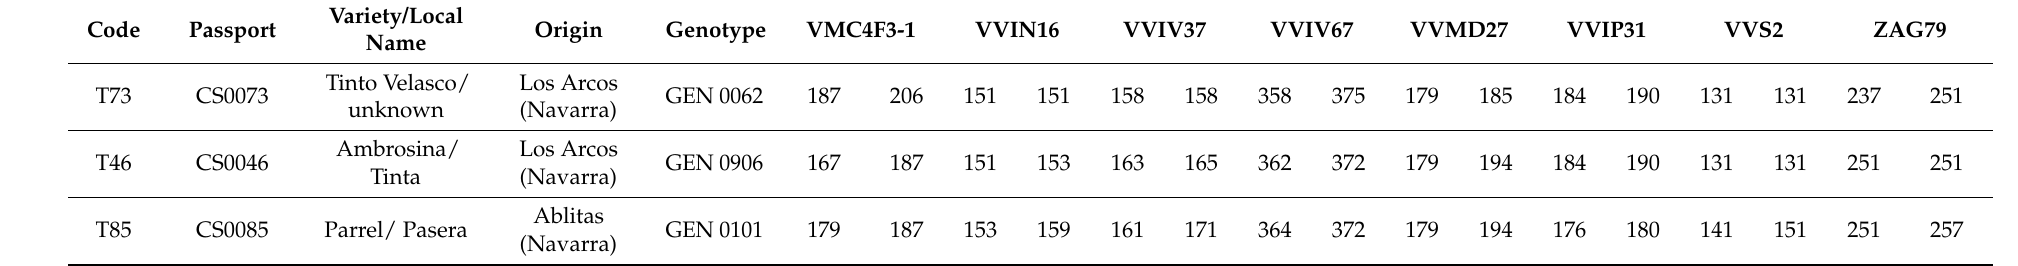
Table 3. Code, passport number, variety name, origin, genotype, and molecular profiles (allele sizes in base pairs) of varieties identified with 8 microsatellite